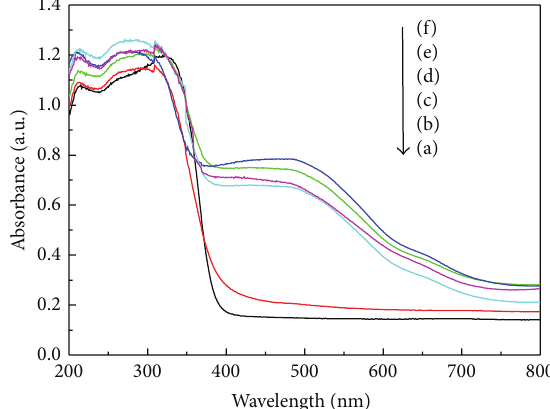
Figure 2: XRD patterns of samples ((a) Fe 3 O 4 @SiO 2 , (b) BSO-0, (c) BSO-0.05, (d) BSO-0.1, (e) BSO-0.2, and (f) BSO-0.3).